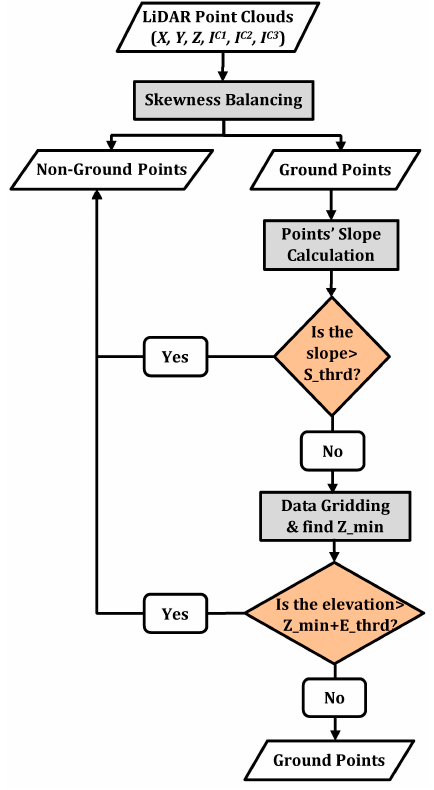
Figure 4. Ground filtering workflow.